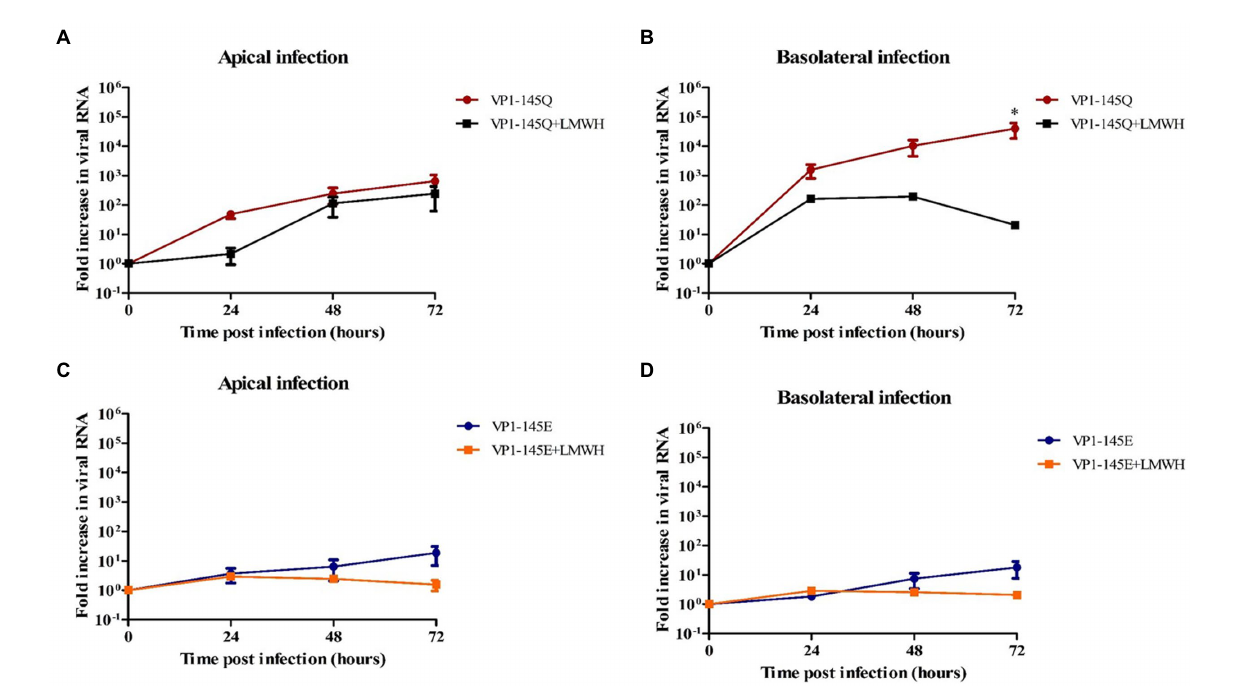
FIGURE 5 The susceptibility of EV-A71 mutants VP1-145Q and VP1-145E to HSPG-binding in fetal intestinal organoid-derived monolayers. (A–D) Fold increase in viral RNA in media collected on different time points from the apical surface after apical (A,C) and basolateral (B,D) inoculation with and without pre- treatment with LMWH. In all cases, data represent the geometric mean ± SEM of four biological replicates with two technical replications per biological replicate. *value of p